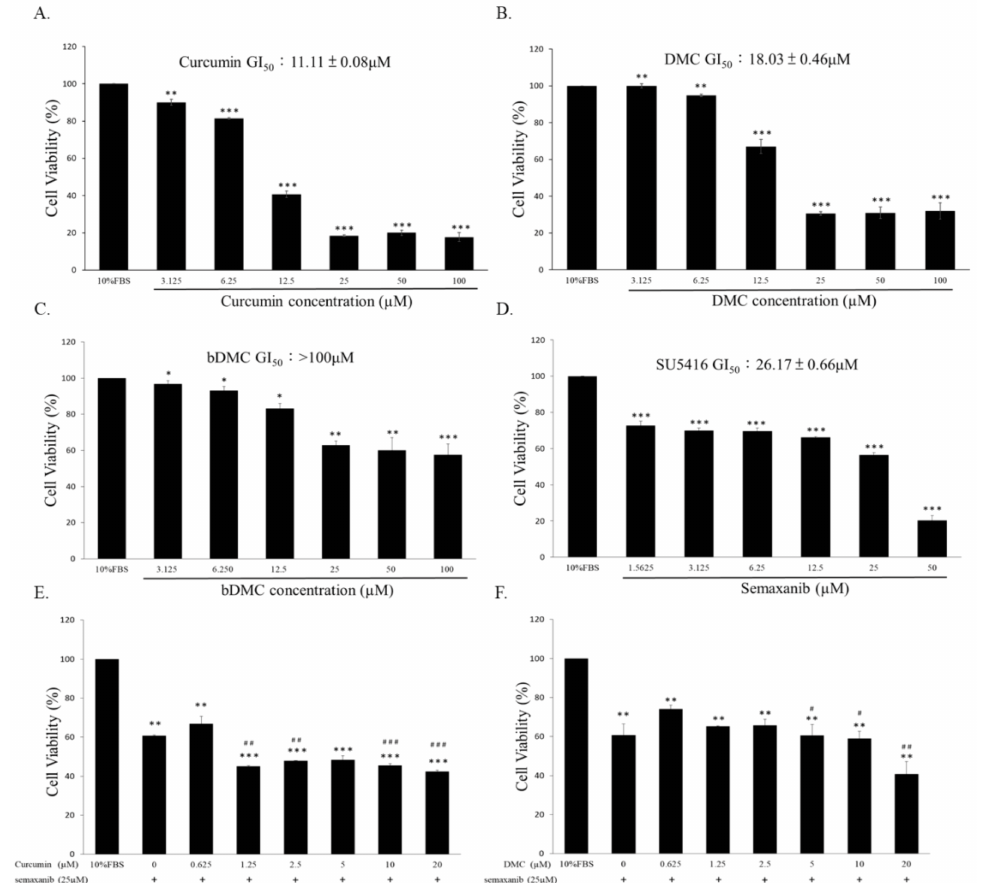
Figure 2. Inhibitory effects of curcuminoids (i.e., curcumin, DMC, and bDMC) alone and combined with semaxanib on HUVECs. ( A – C ) Cell-cytotoxic effects of curcumin, DMC, and bDMC on HUVECs according to SRB assay. ( D ) Cell-cytotoxic effects of semaxanib on HUVECs. ( E ) Combination treatment with curcumin and semaxanib demonstrated significant inhibitory effects on HUVECs compared with the semaxanib-treated group. ( F ) Combination treatment with DMC and semaxanib showed considerable inhibitory effects on HUVECs compared to the semaxanib-treated group.